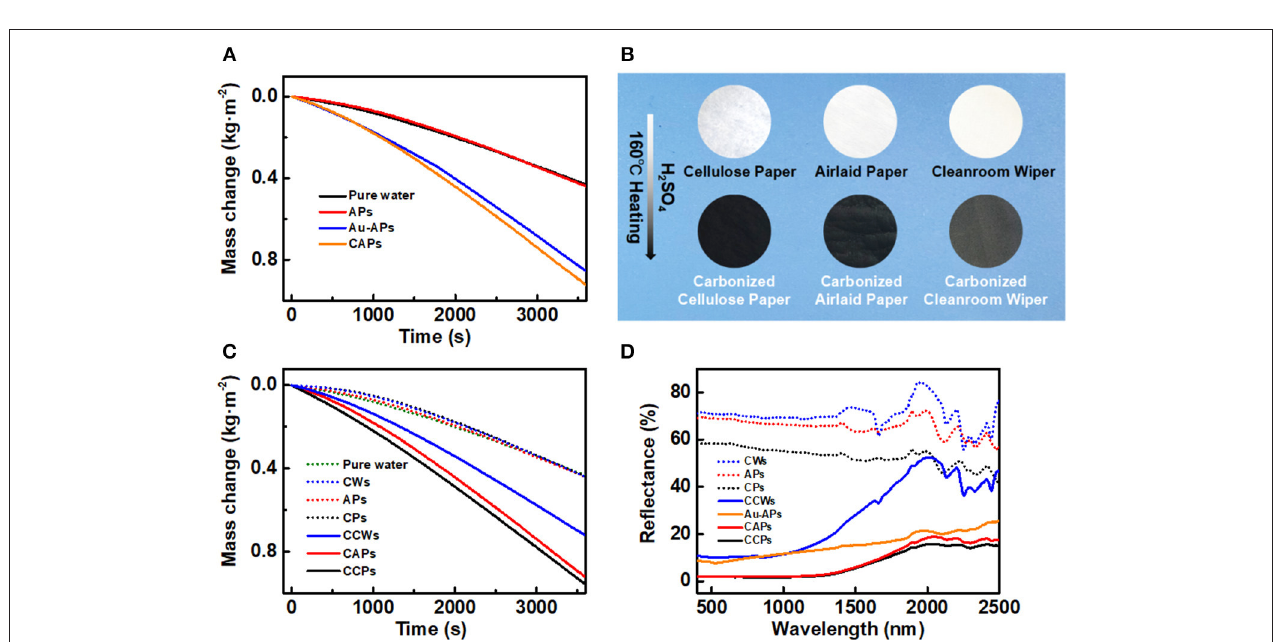
FIGURE 3 | (A) The typical curves of the mass change vs. time for pure water, APs, Au-Aps, and CAPs under 1 sun illumination. (B) The photographs of APs, CAPs, CPs, CCPs, CWs, and CCWs. (C) The typical curves of the mass change vs. time for pure water, APs, CAPs, CPs, CCPs, CWs, and CCWs under 1 sun illumination. (D) The reflectance spectra of Au-APs, APs, CAPs, CPs, CCPs, CWs, and CCWs.